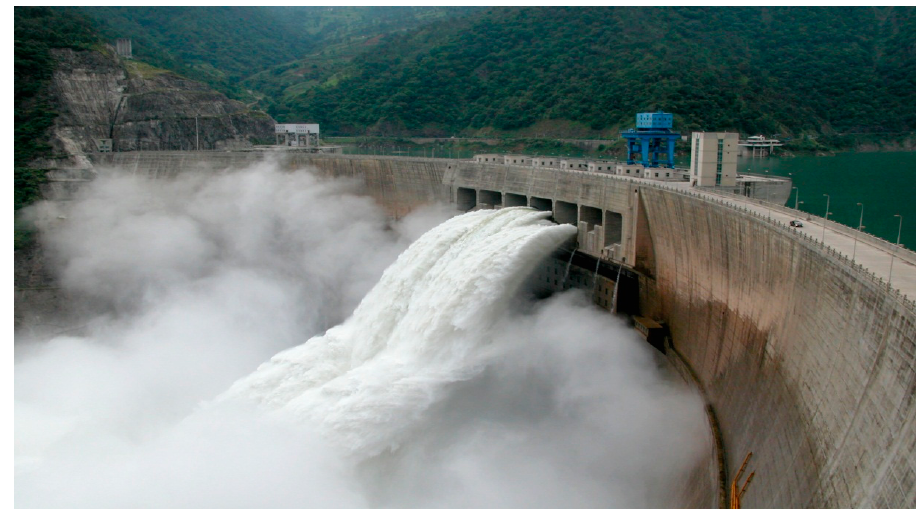
Figure 1. Simultaneous discharge of the surface and the deep hole of the Ertan hydropower station in 2010.